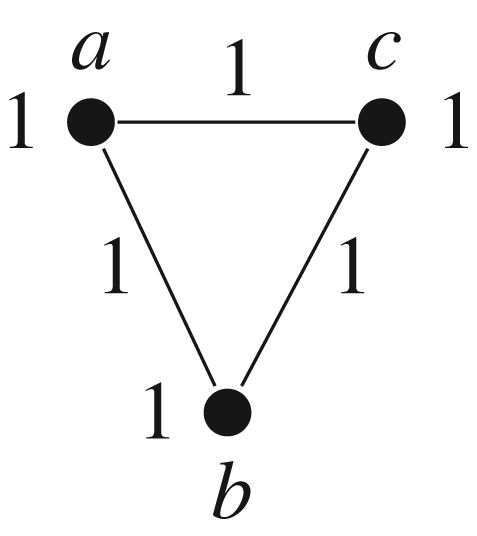
Simplicial complex for topology in figure 2.